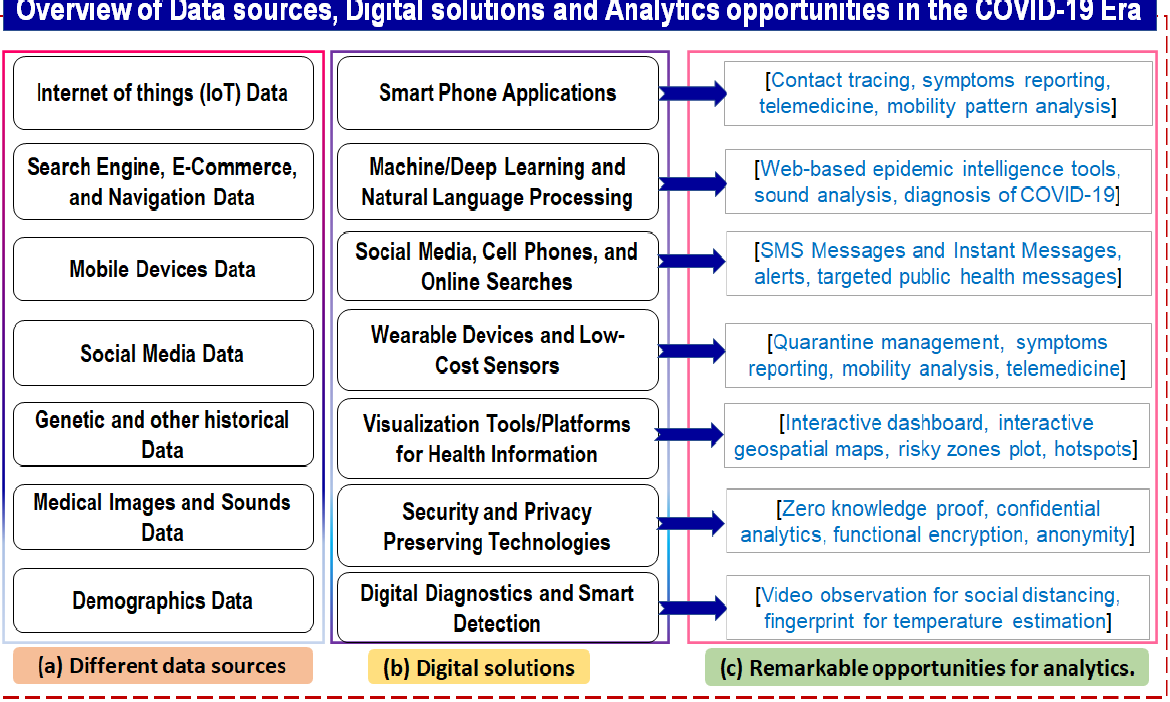
Figure 3. Conceptual overview of the data sources, digital solutions, and analytics (DDA) in the COVID-19